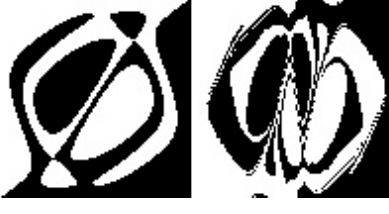
Figure 4. Spirals generated by ten fully successful neural networks evolved by HCAE( Oper2 ).